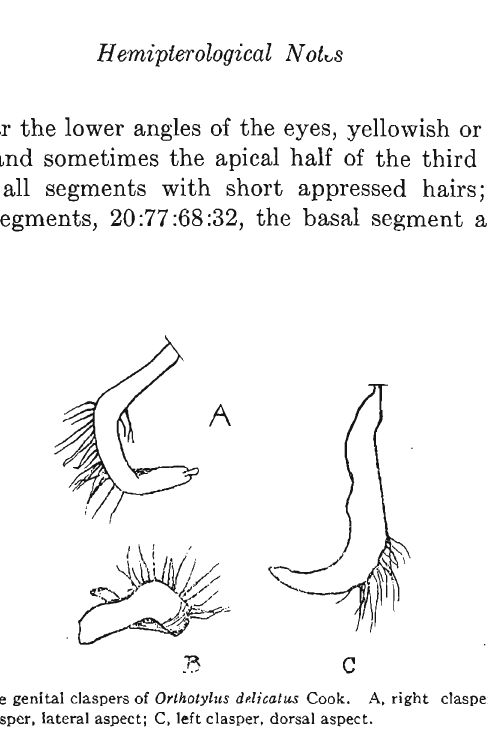
the dorsal aspect of the head., the second segment about one- fourth longer than the basal width of the pronotum.